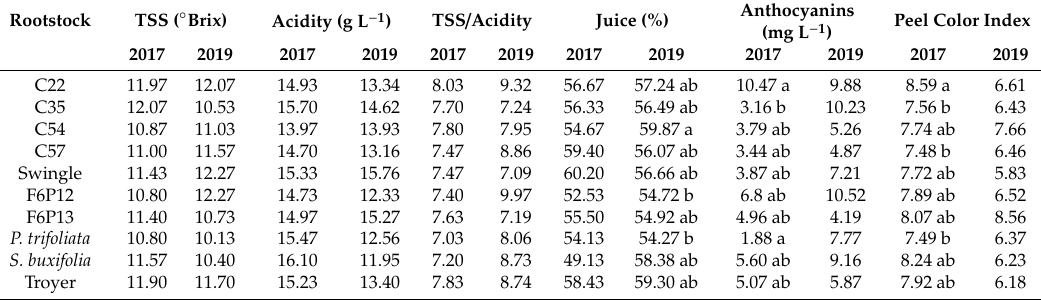
Table 3. Qualitative analysis on Mandared fruits sampled in 2017 and 2019. Di ff erent letters indicate significant di ff erences among rootstocks in each year as determined by Tukey multiple range test ( p ≤